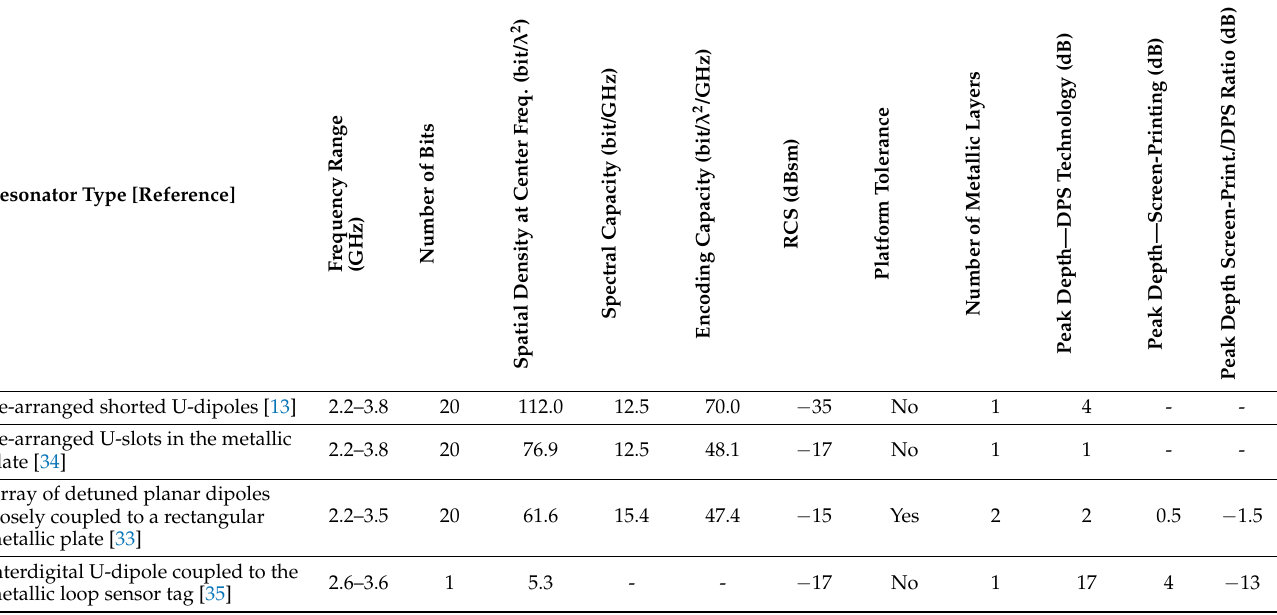
Table 5. Performance comparison of frequency-domain chipless RFID tags.